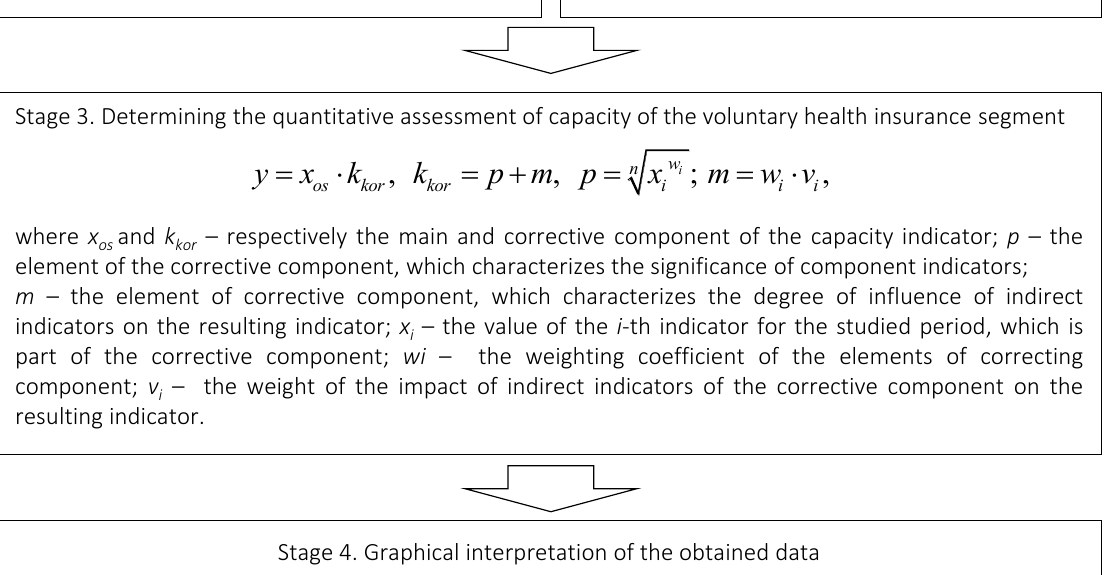
Figure 1. Stages of capacity calculation for the voluntary health insurance